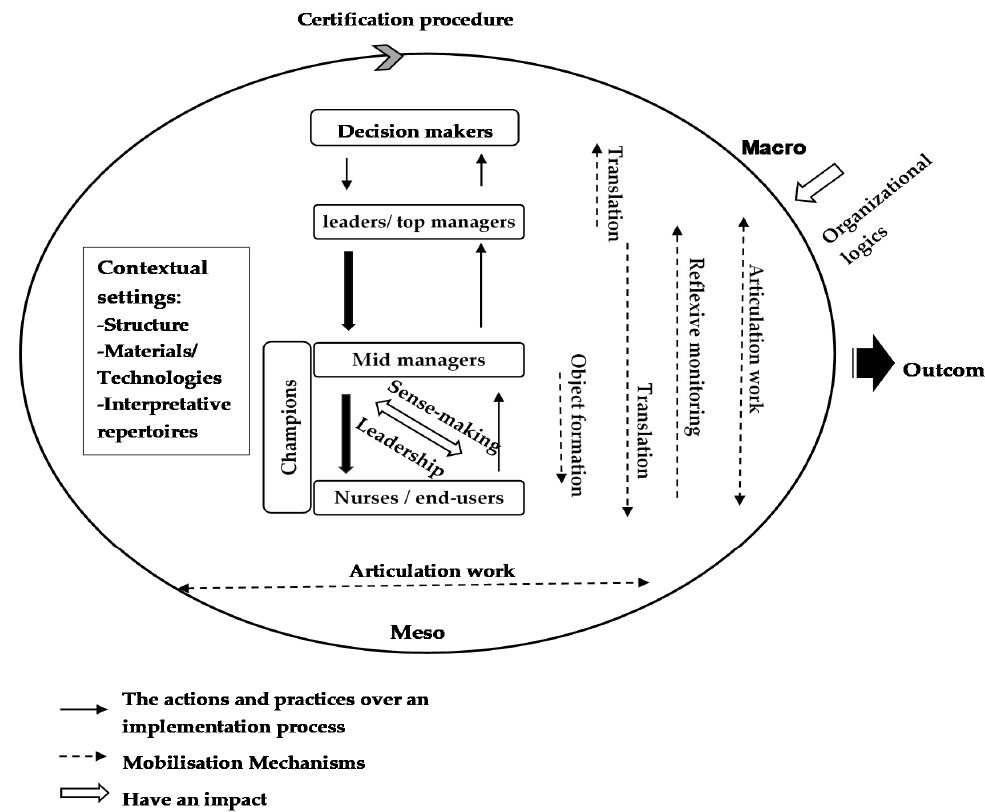
Figure 2. The Integrative Framework for Implementation of change in Nursing Practices (IFINP).